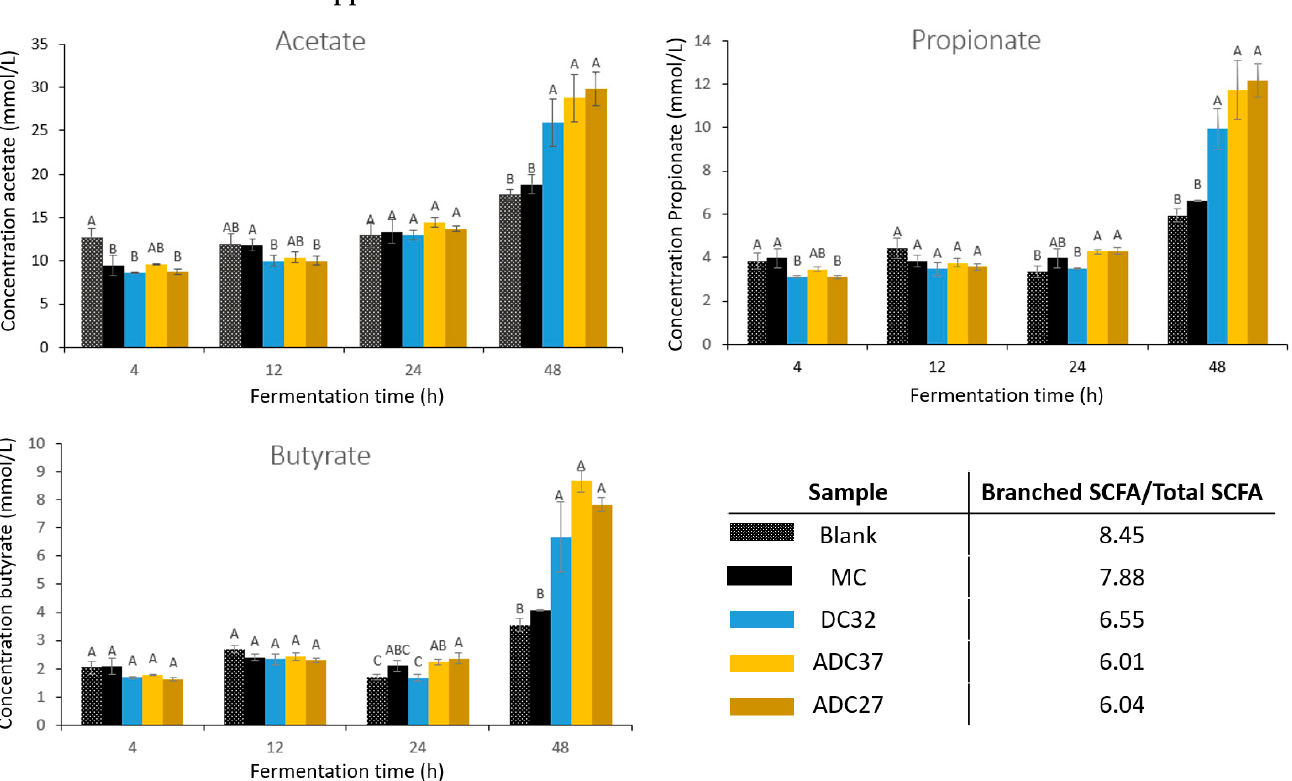
Figure A1. Rietveld refinement analysis of an XRD refractogram of depolymerized cellulose (DC) with an avDP of 32AGU.